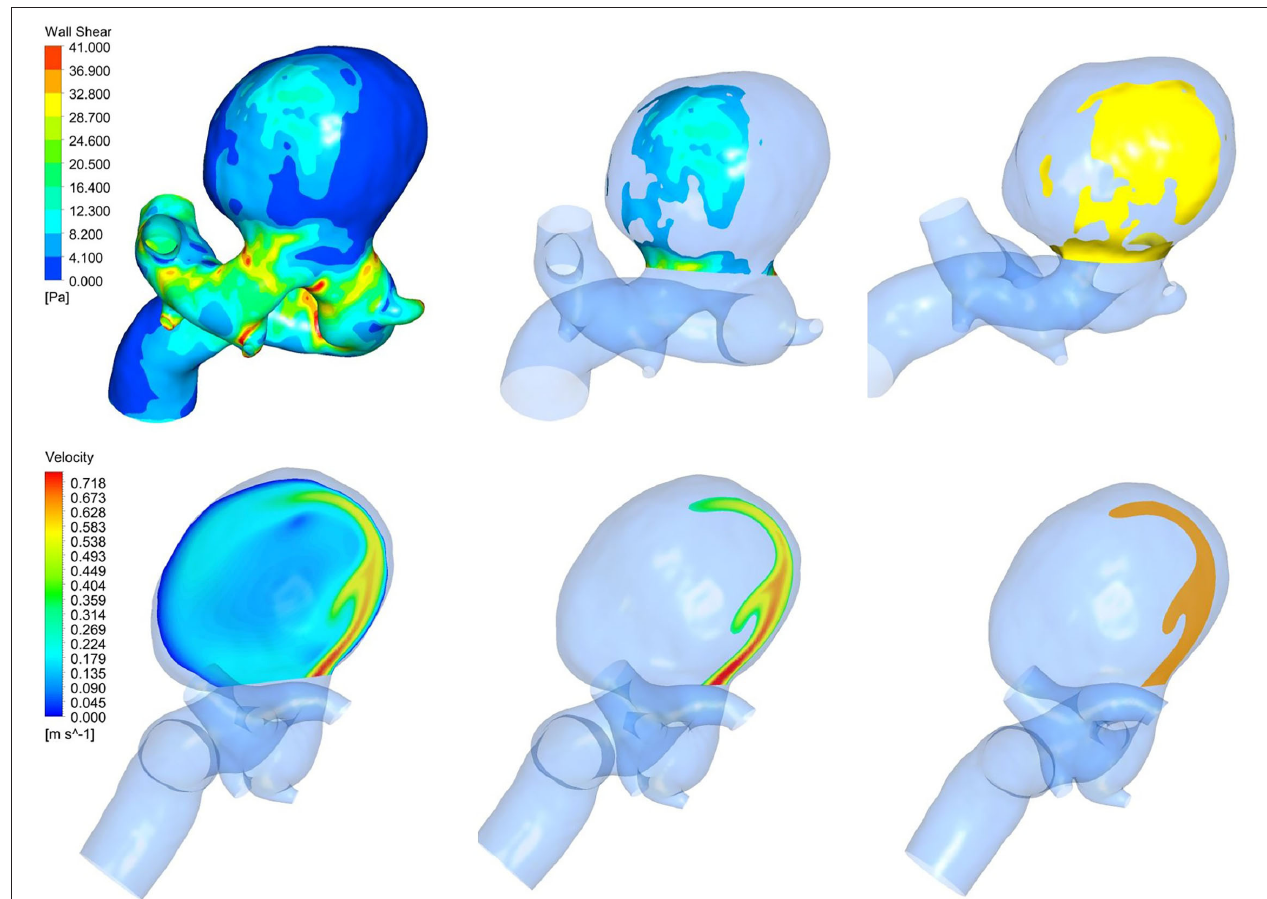
FIGURE 4 | The impingement zone (yellow) and the inflow jet (orange).